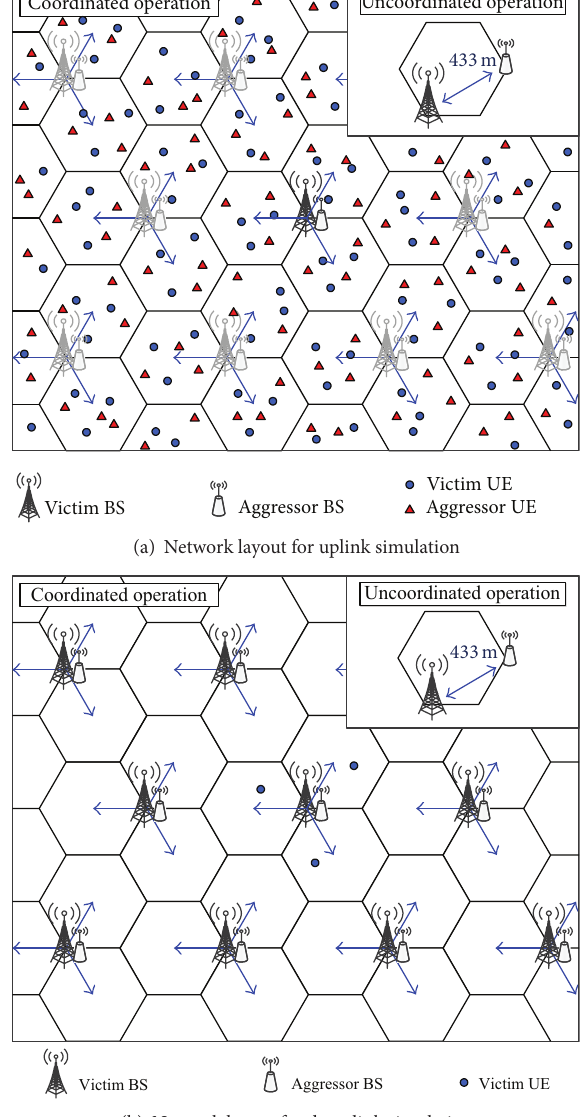
Figure 5: Cell layout for performance